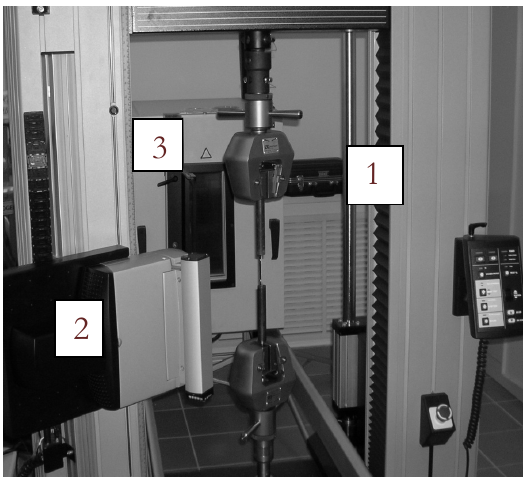
Figure 2: The appearance of the unidirectional fiberglass specimen in grips at tensile tests: Instron 5882 test set (1), video extensometer (2), climate chamber